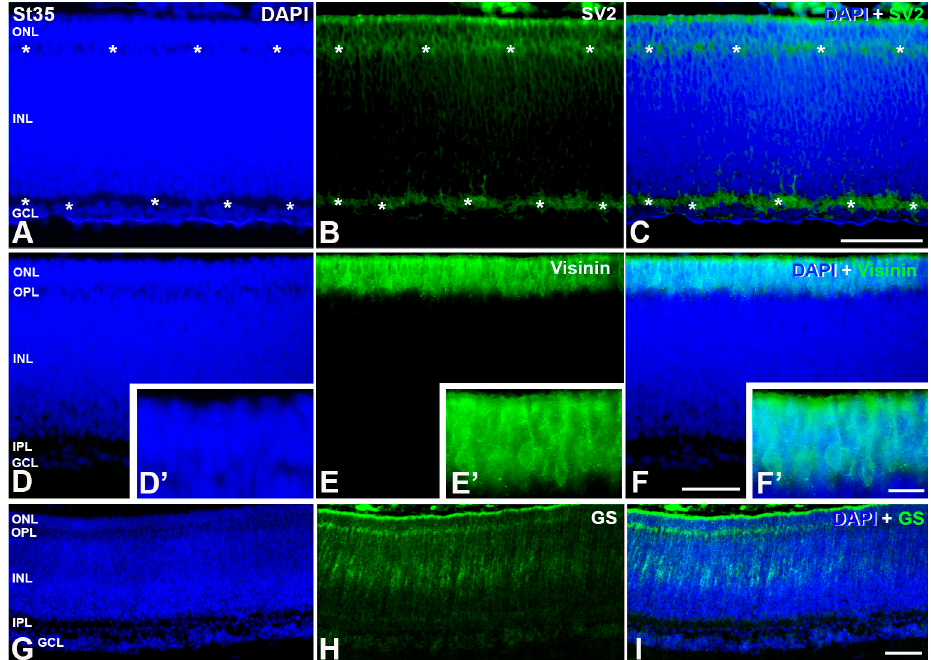
Figure 6. SV2 ( A – C ), visinin ( D – F , D ′ – F ′ ) and GS ( G – I ) immunostaining in retinal cryosections of C. coturnix at St 35 of development. OPL can be observed at this stage as well as IPL (asterisks in ( A )) using SV2-antibody (asterisks in ( B , C )). Visinin-immunosignals is stronger, showing a higher num- ber of photoreceptors ( E , F , E ′ , F ′ ). Müller cells GS-positive are detected for fi rst time ( H , I ). GCL, gan- glion cell layer; INL, inner nuclear layer; IPL, inner plexiform layer; ONL, outer nuclear layer; OPL, outer plexiform layer. Scale bars: 100 µm in ( A – I ); 30 µm in ( D ′ – F ′ ). In newly hatched animals (P0), the quail retina presents a mature aspect. PCNA im- munoreactive nuclei and pHisH3-positive mitotic fi gures are absent from the entire retina (not shown) [19,27]. CR- and TUJ1-immunoreactivities are restricted to subpopulations of cells located in the GCL and in the amacrine cell layer (Figure 7A–D,A ′ –D ′ ). The nuclei of subpopulations of ganglion, amacrine, bipolar, and horizontal cells are immunoreactive for Isl1 (Figure 7E–H). Prox1 is present in the nuclei of all horizontal cells (Figure 7E–H), and some of them are also immunoreactive for Isl1 (Figure 7E ′ –H ′ ). At this age, Prox1 also labels a subpopulation of amacrine cells (Figure 7G,H, arrowheads). Parvalbumin (PV) is almost con fi ned to subpopulations of amacrine cells, with their dendrites laminarly orga- nized in the IPL (Figure 7I–K). Weakly PV staining is also found in the OPL and in some cells located in the outer surface of the GCL (Figure 7I–K). The plexiform layers are well developed and present strong immunoreactivity against SV2 (Figure7L–N). Furthermore, sparse cell somata, located in the amacrine cell layer, are also immunolabelled with this antiserum (Figure 7L–N). Visinin-immunoreactivity can be seen in morphologically ma- ture photoreceptors (Figure 7O–Q). Finally, GS-immunolabelling identi fi es Müller cells which stretch across the entire breadth of the retinal tissue (Figure 7R–T). The immunore- activity is particularly intense in the medial region of the INL, where the Müller cell so- mata are located (Figure 7R–T).